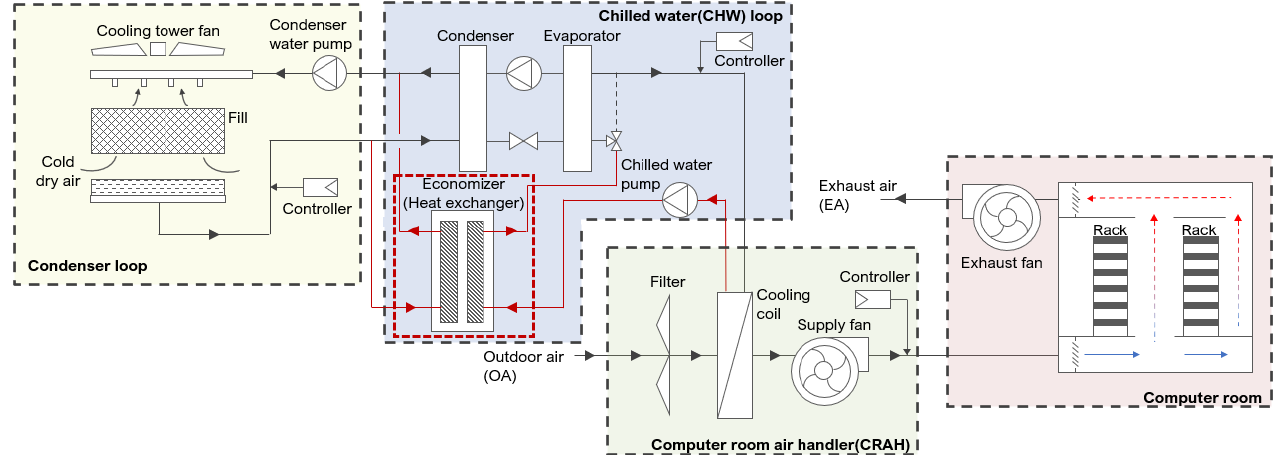
Figure 6. Schematic diagram of WSE.